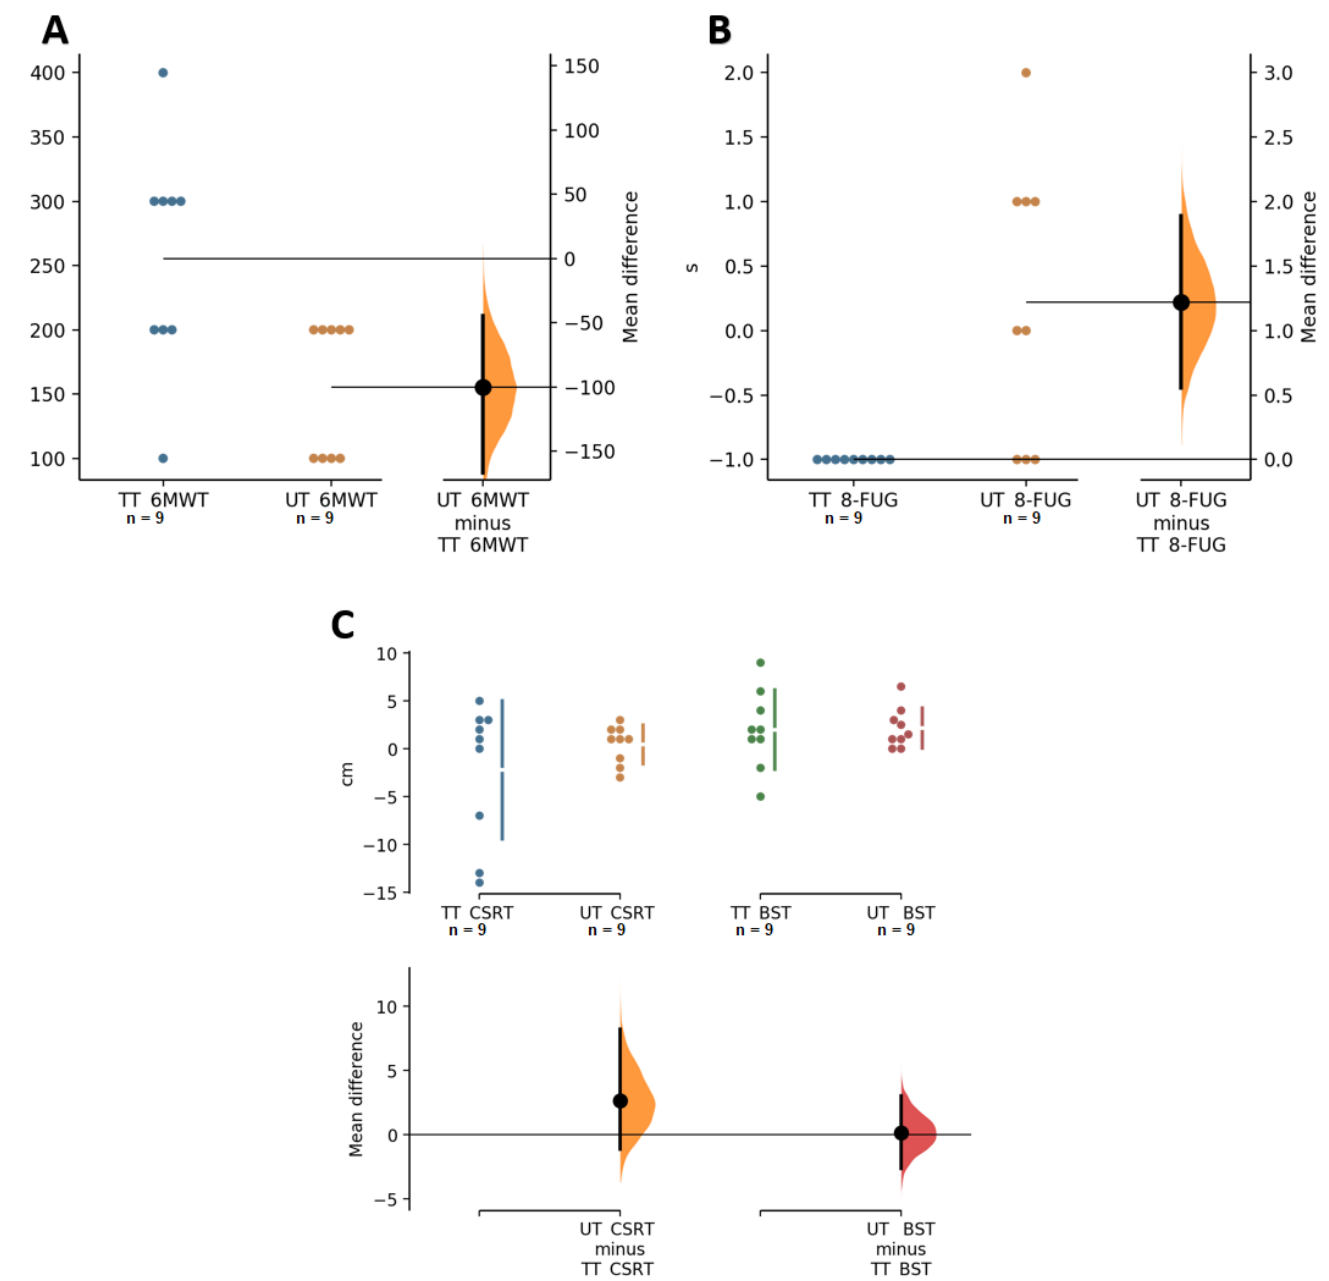
Figure 5. Paired Cumming estimation plots of functional capacity. ( A ) 6 MWT, 6-min six walk test. ( B ) 8-FUG, 8 Foot Up-and-Go Test. ( C ) CSRT, chair sit and reach test, and BST, back scratch test. TT, traditional training; UT, undulating training. The groups are plotted on the left axes; the mean difference is plotted on a floating axis on the right as a bootstrap sampling distribution. The mean difference is depicted as a dot; the 95% confidence interval is indicated by the ends of the vertical error bar [28] .